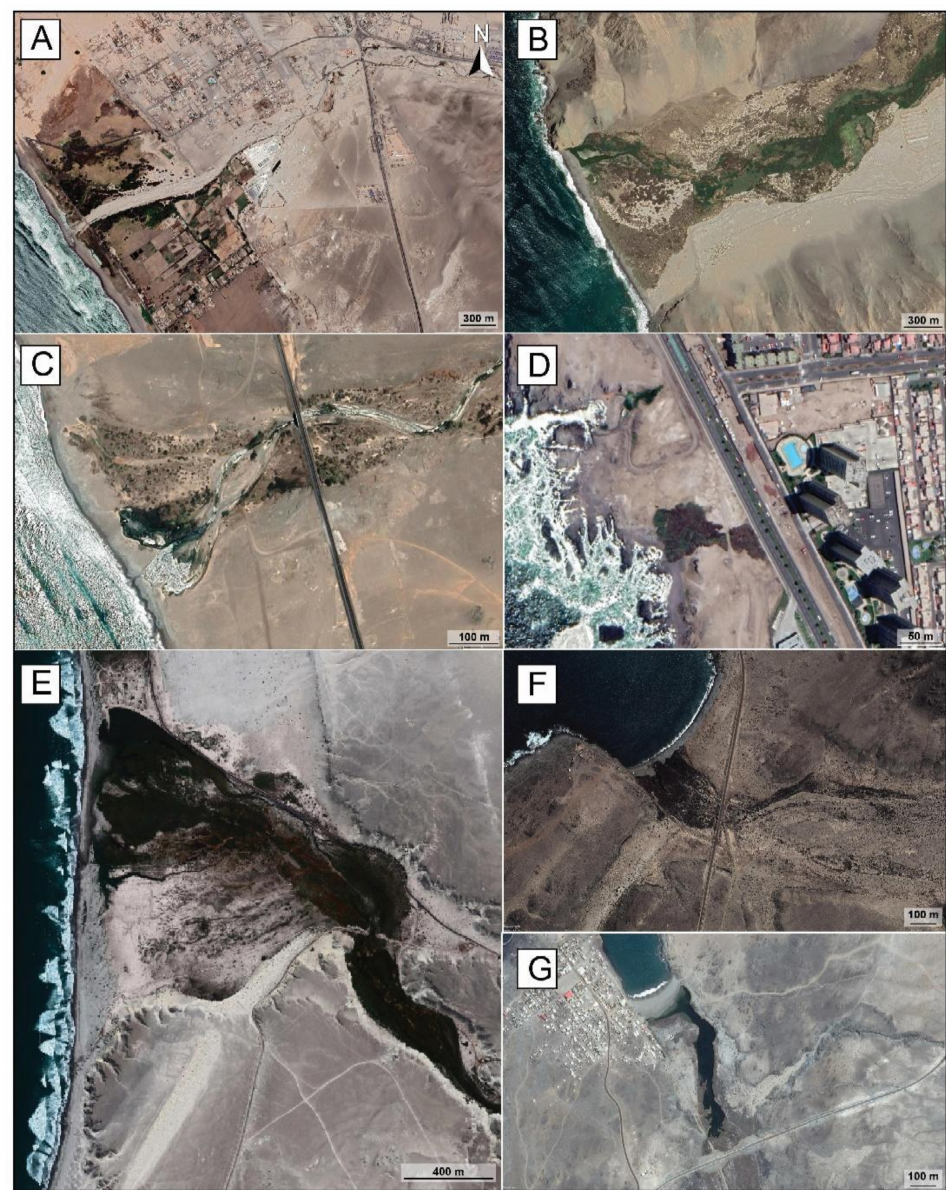
Figure 5. Satellite images of the coastal wetlands analyzed in this work. See location in Figure 3. ( A ) Lluta river wetland; ( B ) Camarones wetland; ( C ) Loa river wetland; ( D ) Chimba wetland; ( E ) Copiap ó river wetland; ( F ) Totoral wetland; ( G ) Carrizal Bajo wetland. Source: Google Earth Pro. The Lluta river mouth wetland was included in the list of 68 Priority Sites for the Conservation of Biodiversity in 2003 and, in 2009 was declared a Nature Sanctuary [61], protecting an area of 30.64 ha. In 2010, it was designated as a shorebird reserve by the Western Hemisphere Shorebird Reserve Network (WHSRN), a science-based, partnership- driven, conservation initiative for the protection of the ecological integrity of critical habitats for shorebirds throughout the Americas. In 2018, the MMA proposed to expand the protection area of the Nature Sanctuary to 372 ha (Table